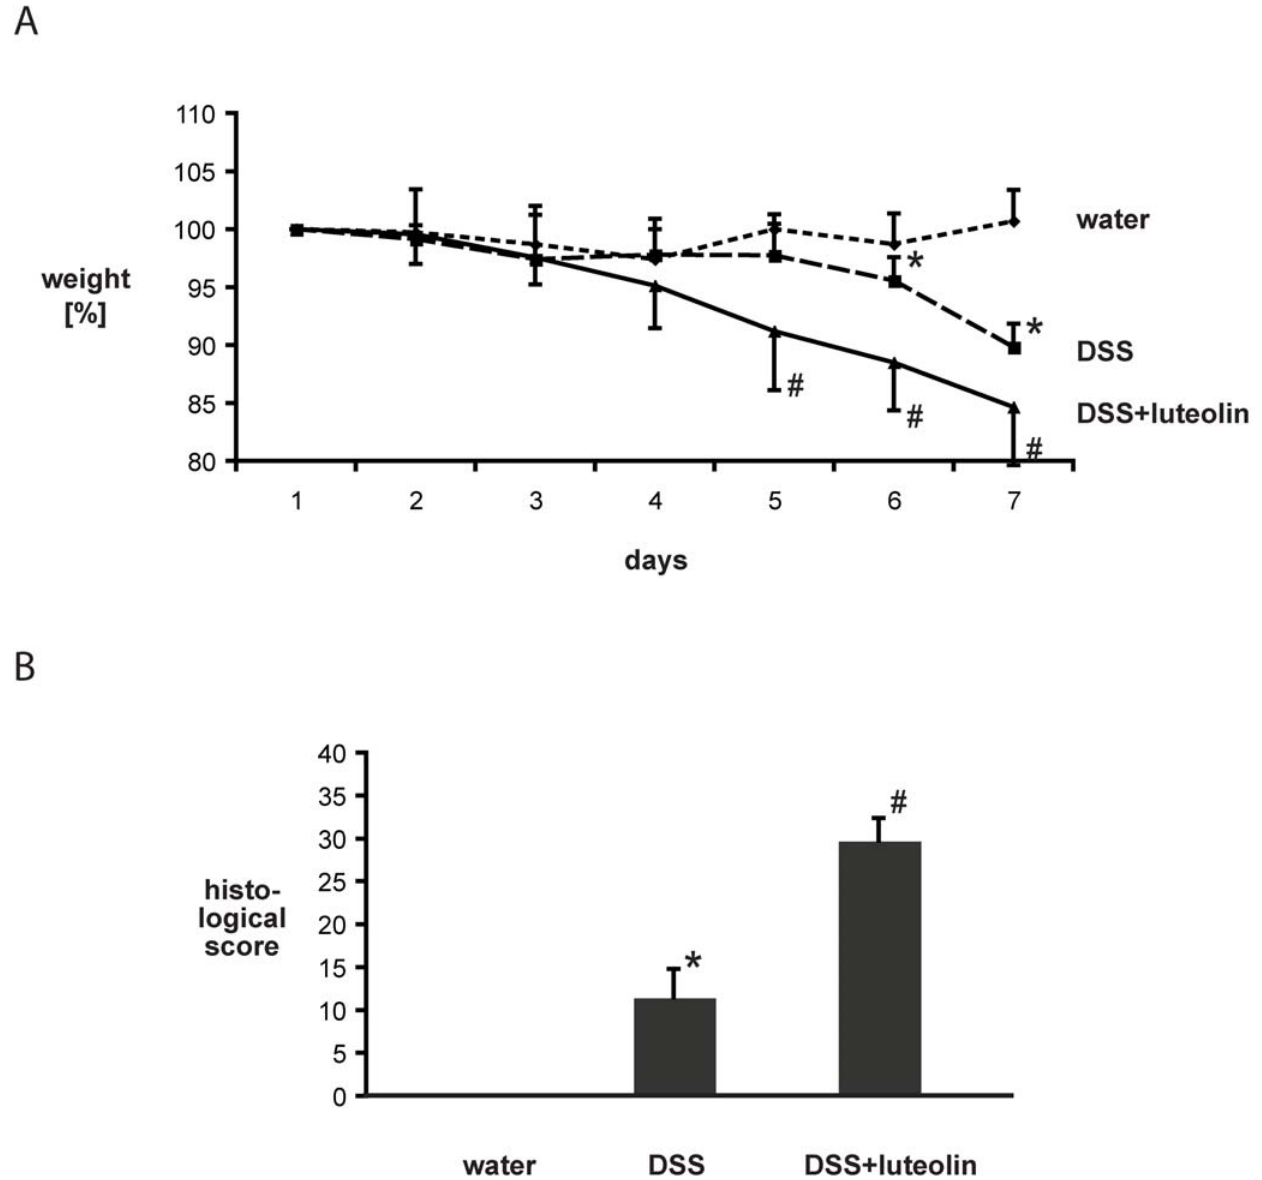
Figure 1. 2% luteolin diet worsens DSS-induced experimental colitis as measured by weight loss and histologic score. 2% luteolin or AIN-76 fed mice (n=7 per group) were exposed to 3% DSS in drinking water ad libitum for the indicated time and monitored as described in the Methods section. Weight loss in response to DSS is presented as percent of the starting weight (* p , 0.05 versus control, # p , 0.05 versus DSS alone) (A). Colonic histological sections were scored as described in the Methods section (* p , 0.05 versus control, # p , 0.05 versus DSS alone)